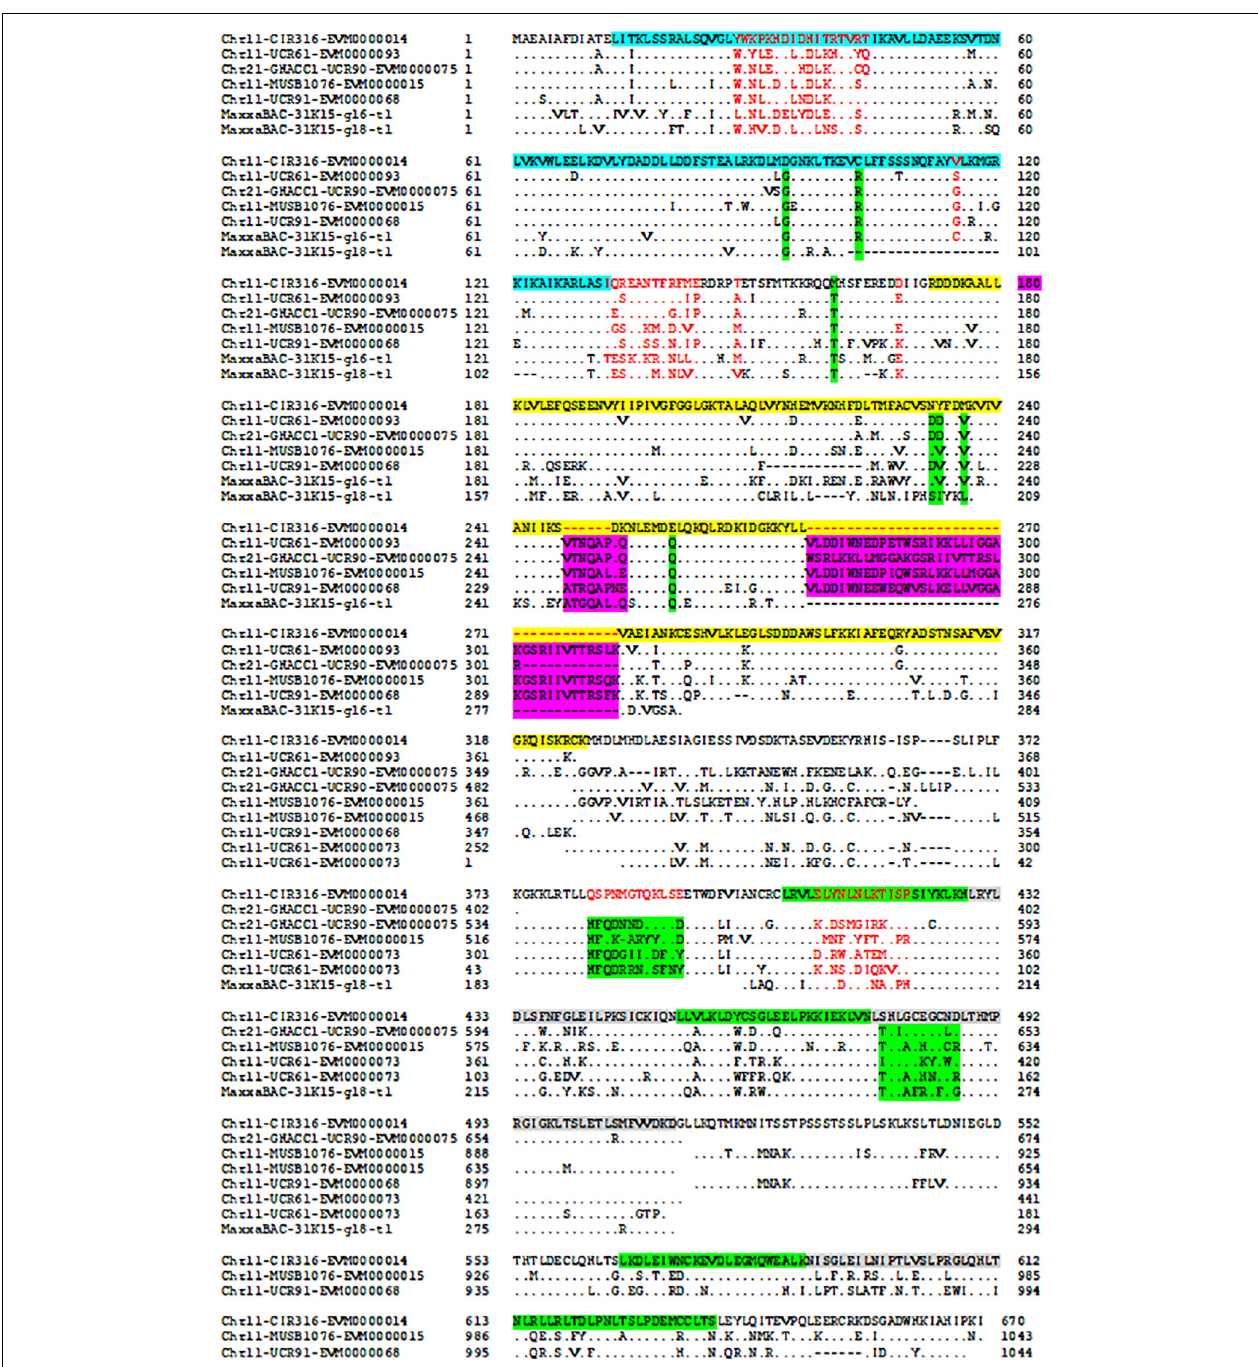
FIGURE 3 | Alignment of disease resistance protein (CC)-NBS-LRR among BACs on Acala N901 Chr11-21 BACs and Acala Maxxa BAC 31K15 (Wang et al., 2015) in the rkn1 region. The sequence in light blue in the first line represents CC domain, with NB-ARC domain in yellow and LRR domains in green and gray.